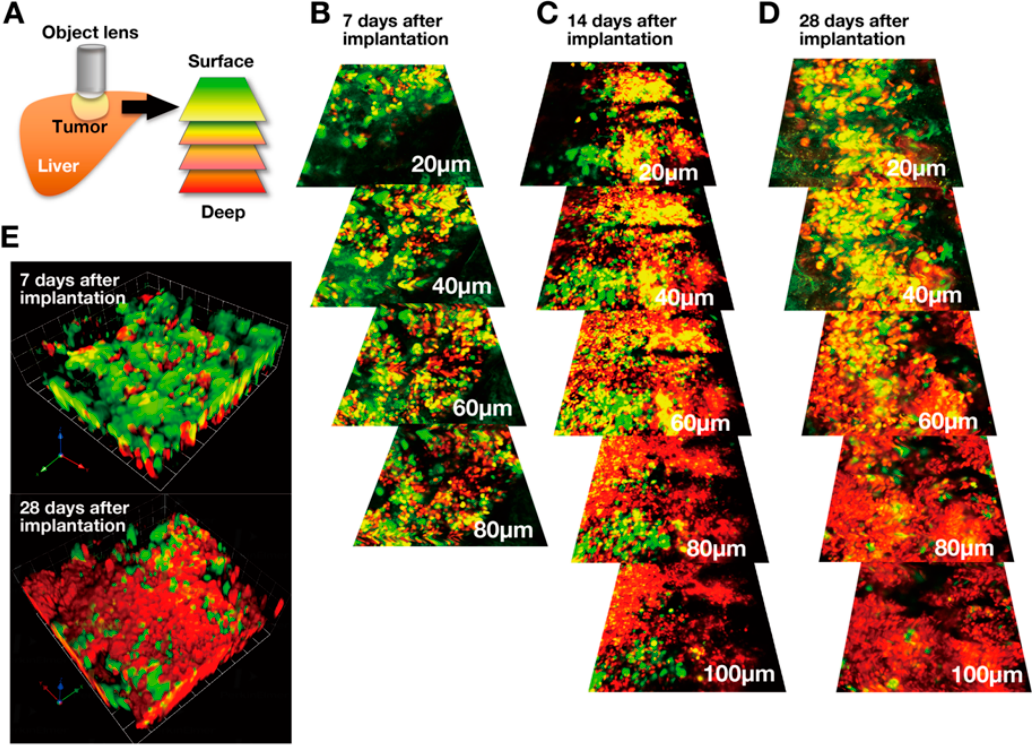
Figure 4. Intravital FUCCI imaging of tumors at various stages and depths. ( A ) Scheme of intravital imaging of FUCCI cancer cells in the liver of nude mice with a confocal laser microscope. ( B – D ) Representative images of FUCCI ‐ expressing tumors at various stages, at the indicated depth from the surface. ( E ) Representative images of 3D reconstruction of FUCCI tumors at 7 and 28 days of growth. The cells in G 1 , early ‐ S, or late ‐ S/G 2 /M phases appear red, yellow, or green, respectively [8].